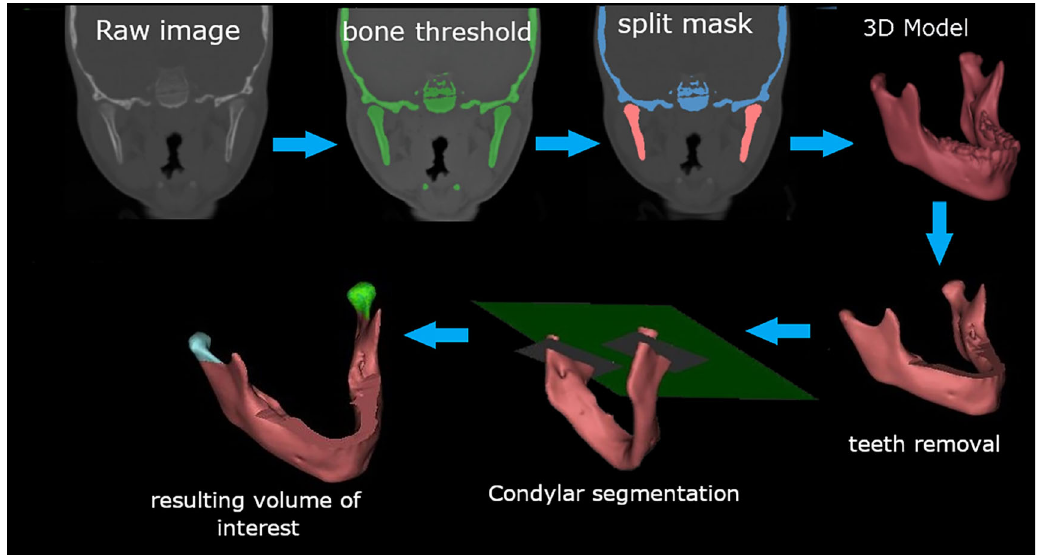
Figure 3. Workflow of the image processing